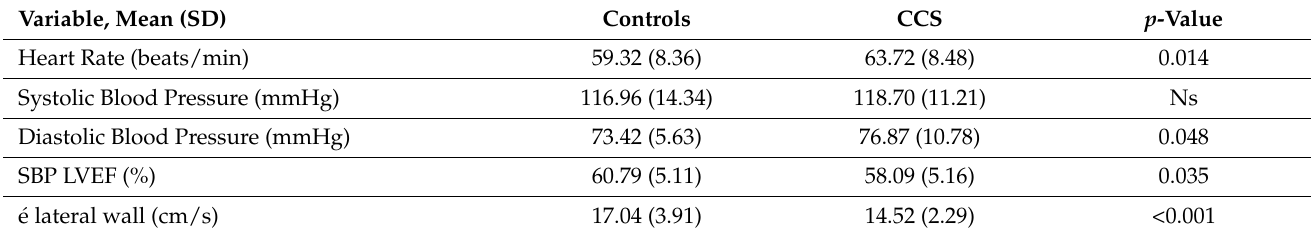
Table 3. Means and estimated means of Baseline cardiac parameters in CCS exposed to cardiotoxic treatments compared to in healthy